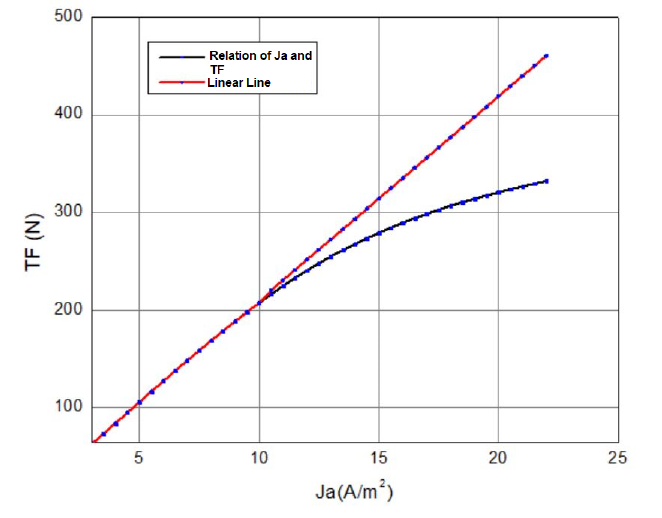
Figure 12. TF at different current densities.